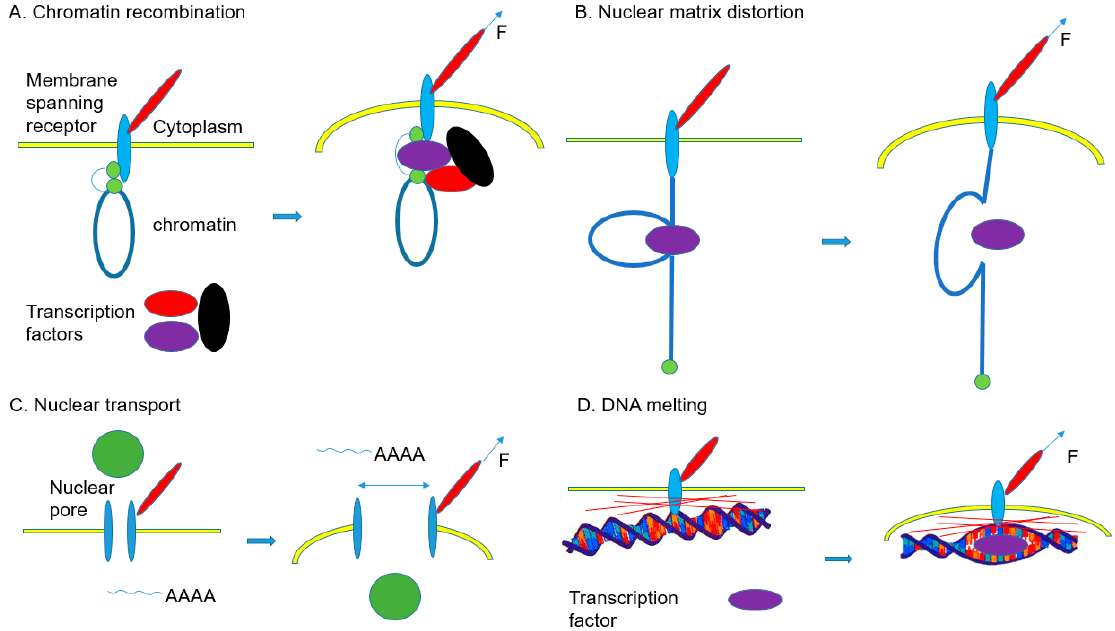
Figure 7. Mechanisms of gene regulation by mechanical stimuli [153]. ( A ) External mechanical forces deform nuclear scaffolds and chromatin organization, thereby altering assembly of transcription factors for gene regulation. ( B ) Forces transferred to specific chromatin regions tethered to lamins or other nuclear membrane receptors regulate the activities of assembled transcription factors or